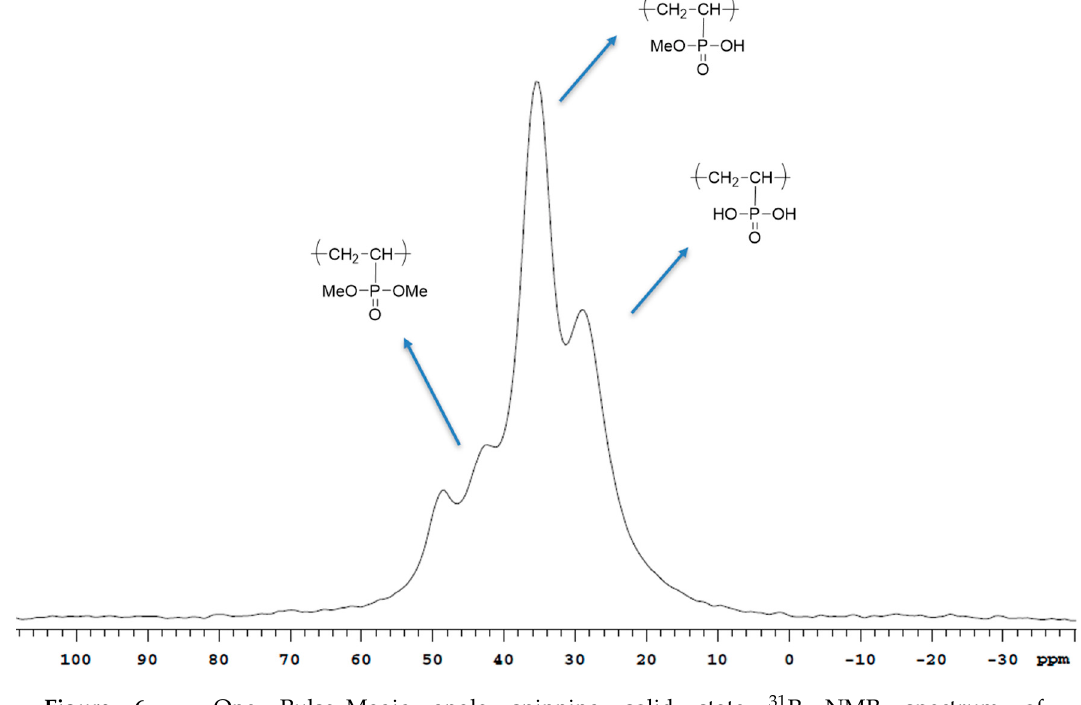
Figure 6. One Pulse–Magic angle spinning solid state 31 P NMR spectrum of poly(VDF- ter -VDMP- ter -VTEOS) terpolymer after hydrolysis and crosslinking ( CP 20 ).